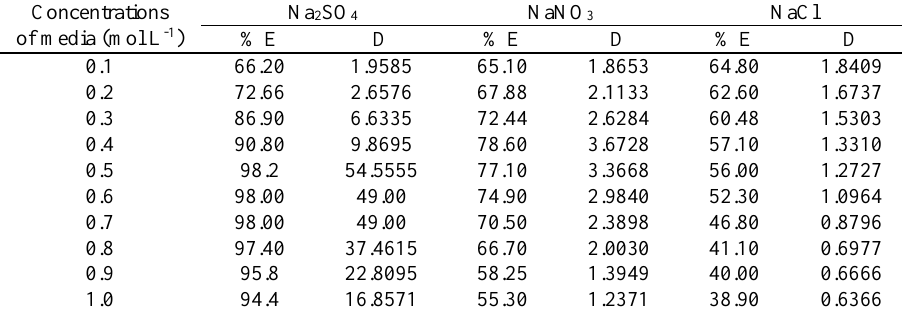
Table 1. Effect of different media on extraction of copper (II).